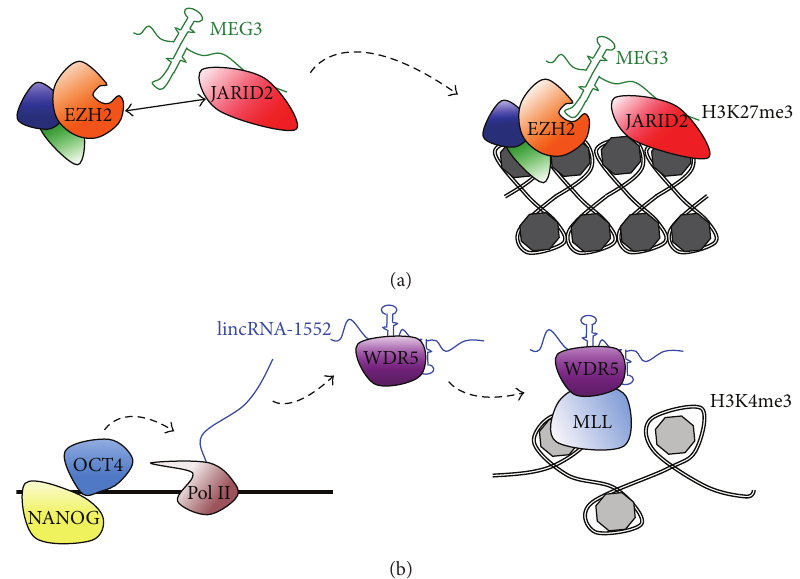
Figure 1: Examples of nuclear lncRNAs interacting with chromatin regulators in ESCs. (a) The lncRNA MEG3 promotes the interaction between the EZH2 subunit of PRC2 and JARID2, thus guiding PRC2 recruitment and H3K27me3 deposition at JARID2 target sites [47]. It has also been proposed that lncRNAs specify the target site recognition of PRC2/JARID2 via RNA-DNA base-pairing (not shown) [47]. (b) lincRNA-1552 transcription is promoted by core pluripotency factors and is required for ESC self-renewal [29]. This and other transcripts positively regulate TrxG activity by binding and stabilizing the WDR5 cofactor